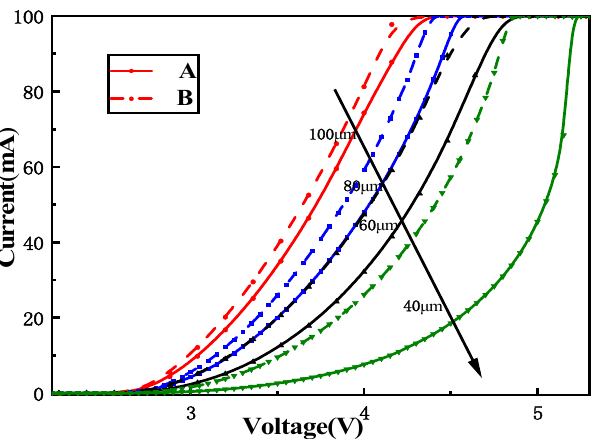
Figure 2. I–V curves of Micro LEDs with ITO size smaller than (A) and equal to (B) the light-emitting area size.